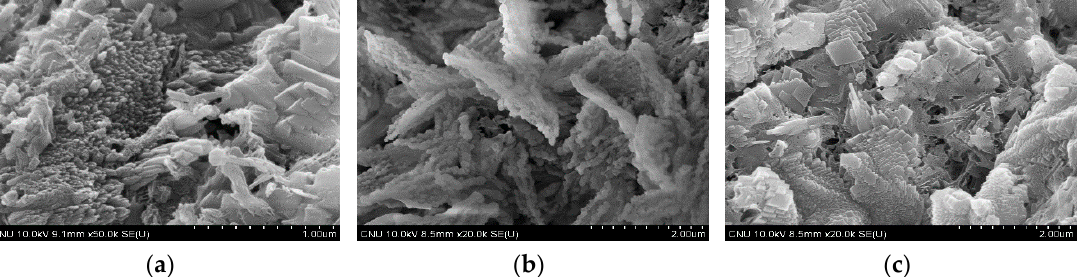
Figure 6. SEM analysis results for barium oxide and strontium oxide—( a ) Sr-oxide; ( b ) Ba-oxide; and ( c ) Ba-oxide.